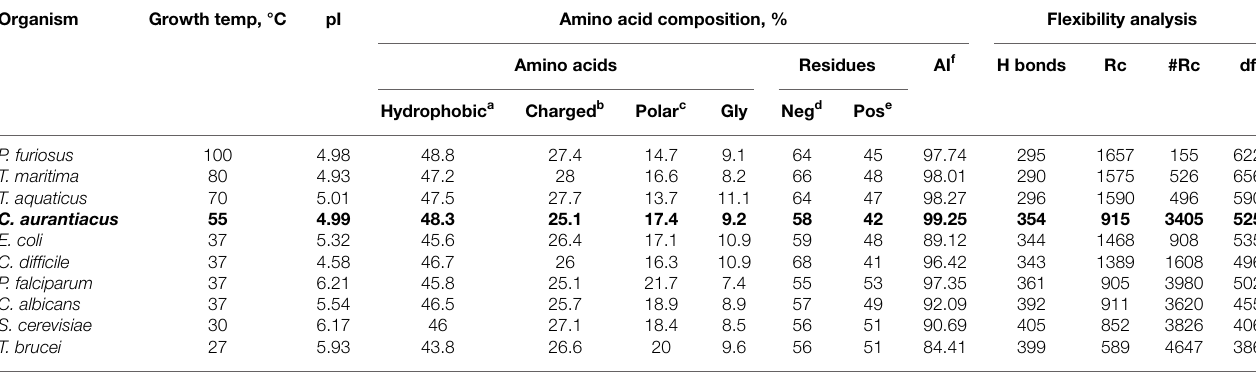
TABLE 1 | Amino acid composition and flexibility analysis of enolases from different microorganisms . Organism Growth temp, °C pI Amino acid composition, % Flexibility analysis